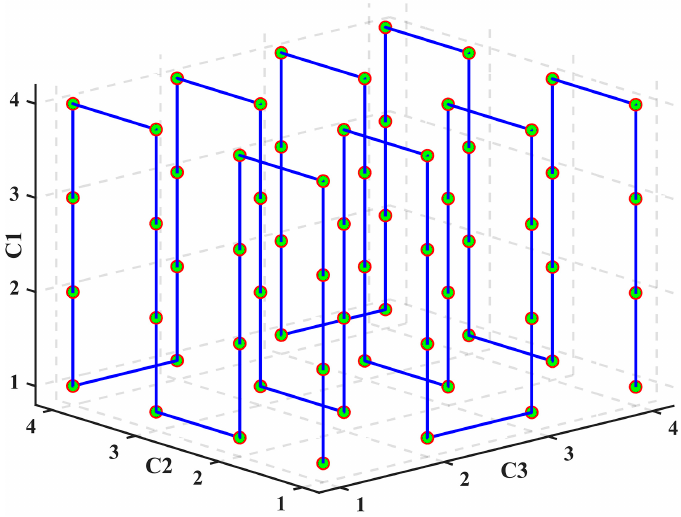
Figure 3. The n -ary gray-code ( n GC) method used in this paper.